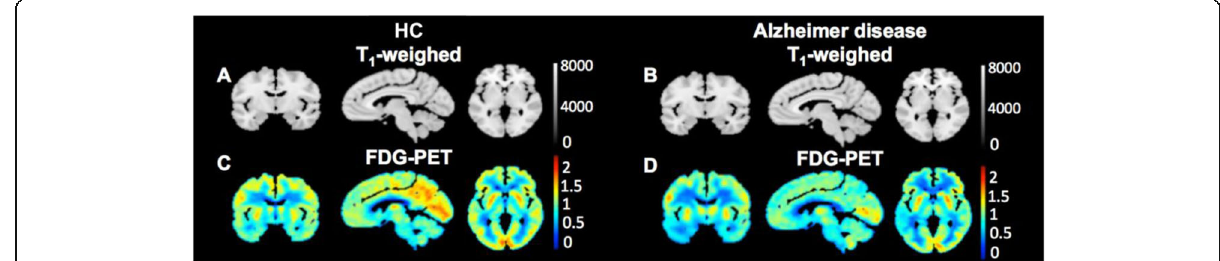
Fig. 3 Modality of PET/CT. The standardized glucose uptake value ratios (SUVR) relative to the cerebellum from 18F-FDG PET scans of a healthy control (HC) and an Alzheimer ’ s disease patient. Adapted with permission from Kazemifar et al. 2017